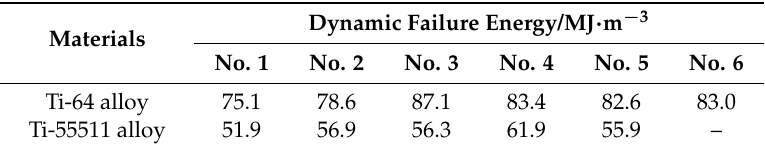
Table 4. Calculation of dynamic failure energy of FHS specimens.